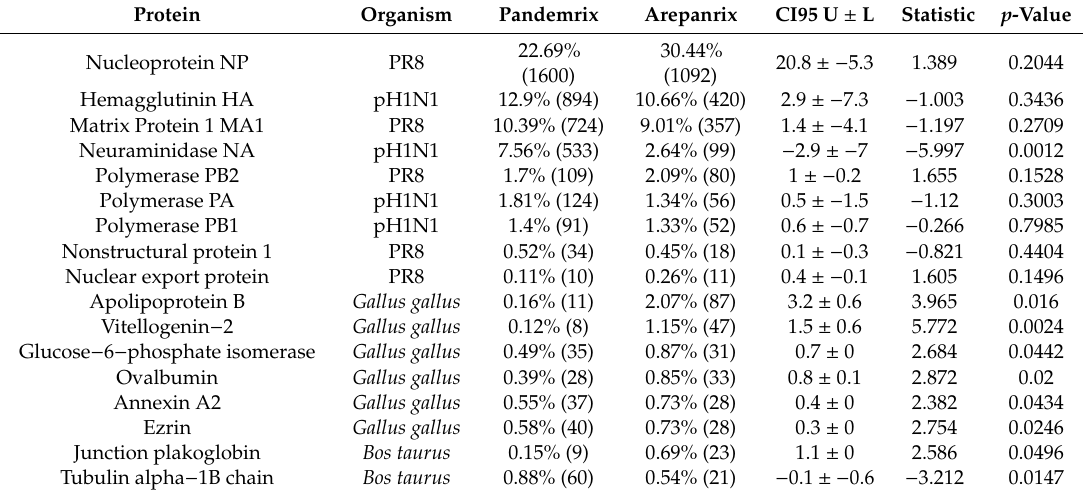
Table 2. The protein content of Arepanrix and Pandemrix.